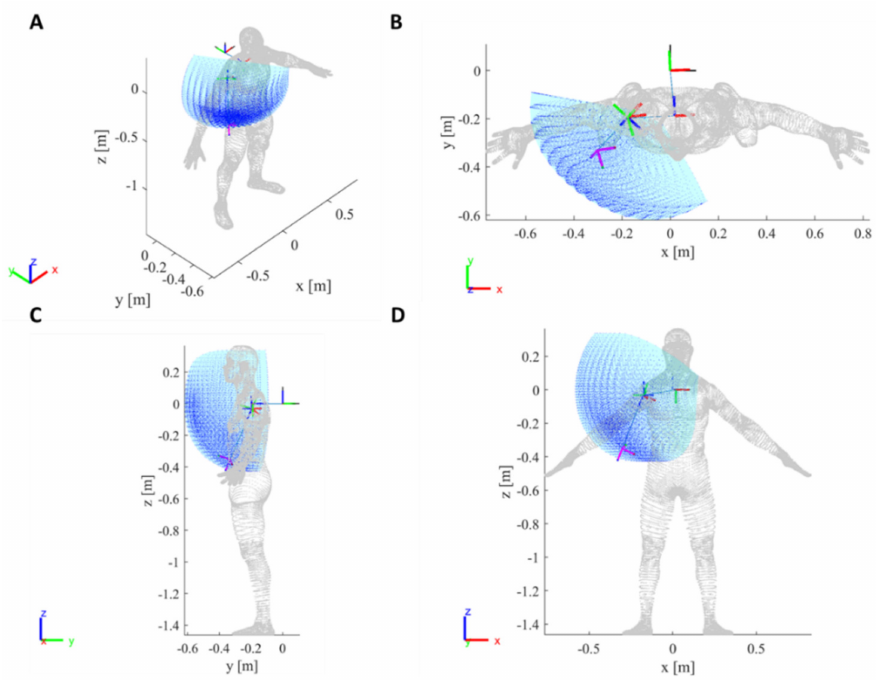
Figure 10. Float exoskeleton cloud point of the end-effector (elbow) from different angles. ( A – D ) offer different view angles for the same cloud